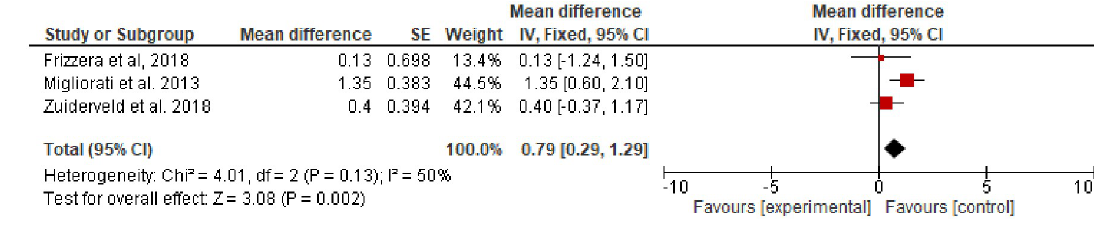
Fig 6. Pink aesthetic score SCTG vs no graft along with